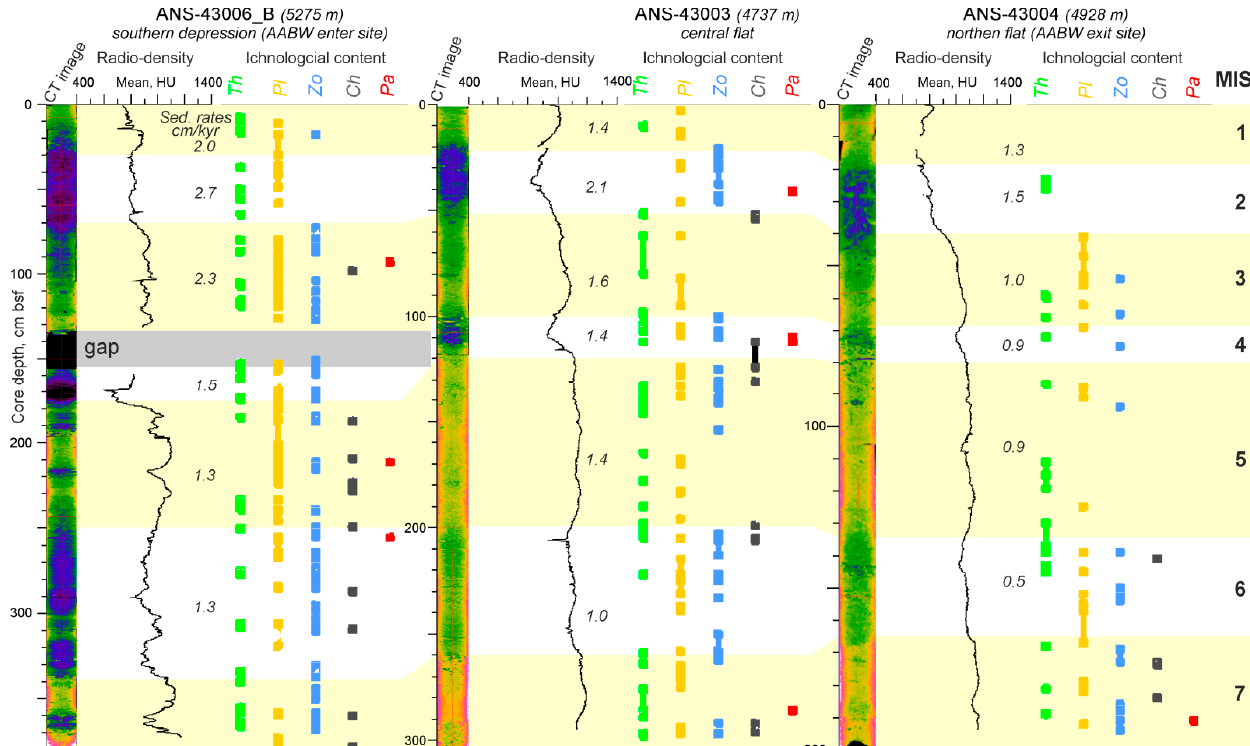
Figure 7. CT-scanning and ichnological content of the studied sediment cores. Stratigraphic subdivision according to [14]. Note the different lengths of the cores and variable sedimentation rates (Italian type numbers). MIS—Marine Isotope Stage, HU—radio-density in the Hounsfield units. Th, Thalassinoides; Pl, Planolites; Zo, Zoophycos; Ch, Chondrites; Pa, Palaeophycus .